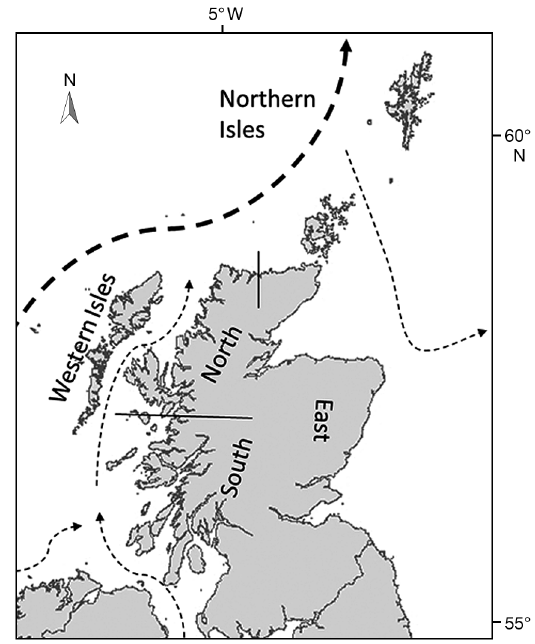
Fig. 1. Map of Scotland showing prevailing ocean current (thick dashed line) and coastal currents (thin dashed lines); see Baxter et al. (2011) for more details. For model analyses, the country is divided into Northern Isles, Western Isles, and northern and southern mainland regions (an east mainland region lacks marine salmon farms). The many small inlets in these regions (lochs and voes) form the units for analysis that are detailed in MSS